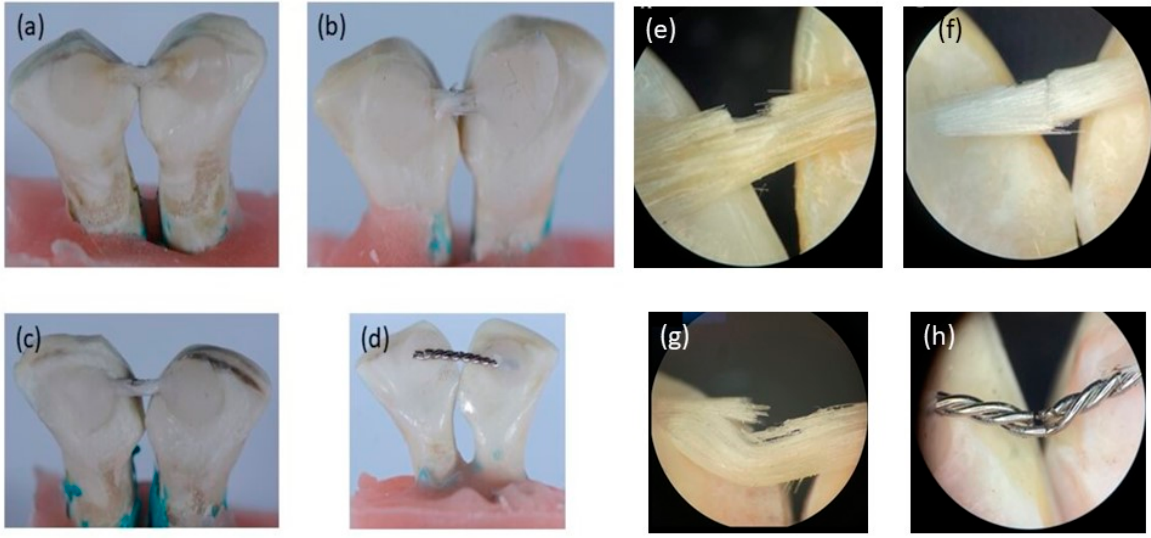
Figure 4. Microscopic images at different magnifications of ( a , e ) nHA/EG, ( b , f ) EG, ( c , g ) EST, and ( d , h ) SS retainers showing the retainer’s surface after cycling load (120,000 cycles) in compression mode.